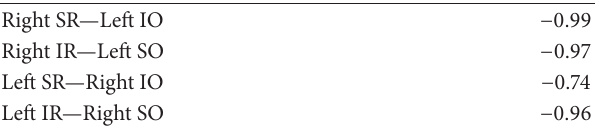
Table 2: Pearson correlation in ocular motility.